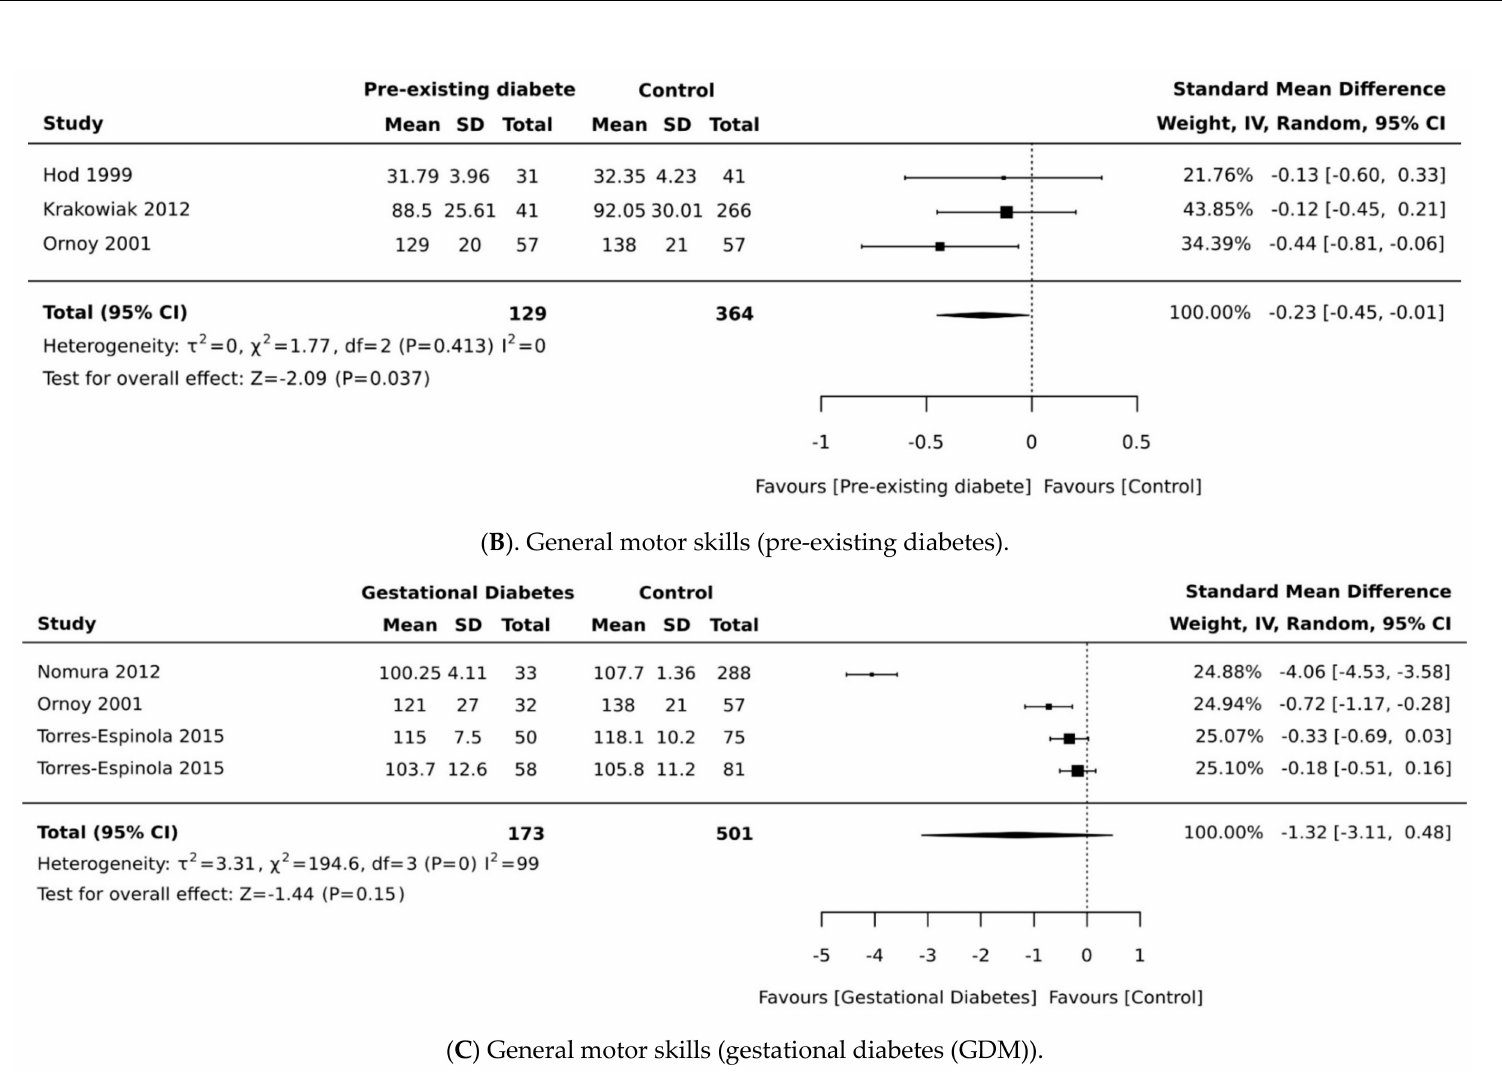
Figure 2. Effects of maternal pregnancy on general motor development. Forest plots comparing the differences in ( A ) motor development in all type of diabetes, ( B ) motor development between children born to mothers with pre-existing diabetes and no diabetes, and ( C ) forest plots comparing the differences in motor development between children born to mothers with and without gestational